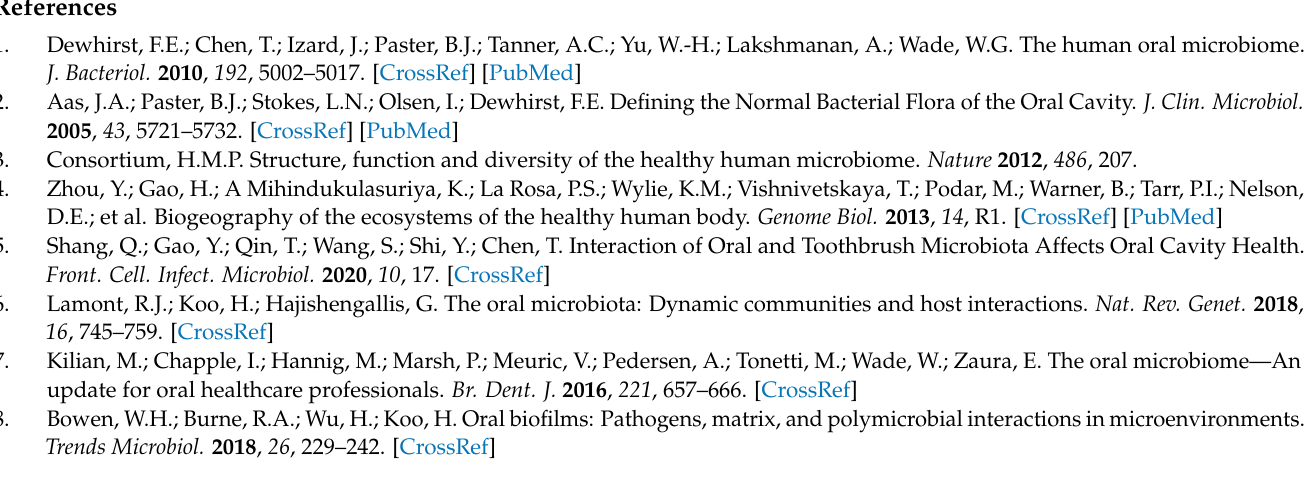
Unifrac distances, Table S1: p -value list, Table S2: Characteristics of the subjects, Table S3: Inclusion and exclusion criteria, Table S4: OTU